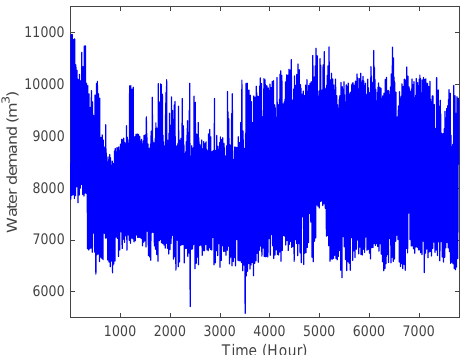
Figure 4. Original hourly water demand data from 1 January 2016 to 21 November 2016.